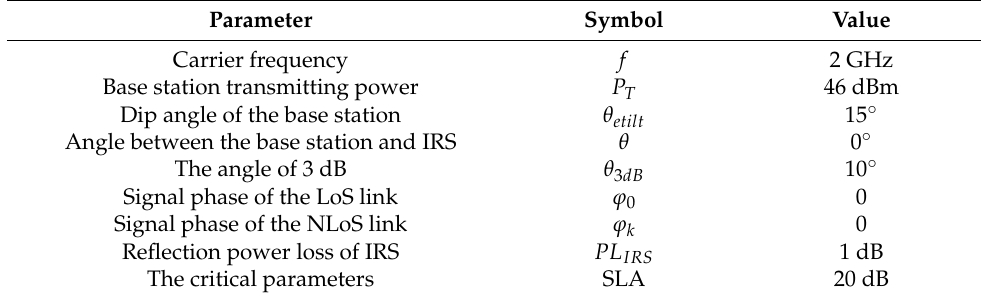
Table 1. Parameter symbols and values.